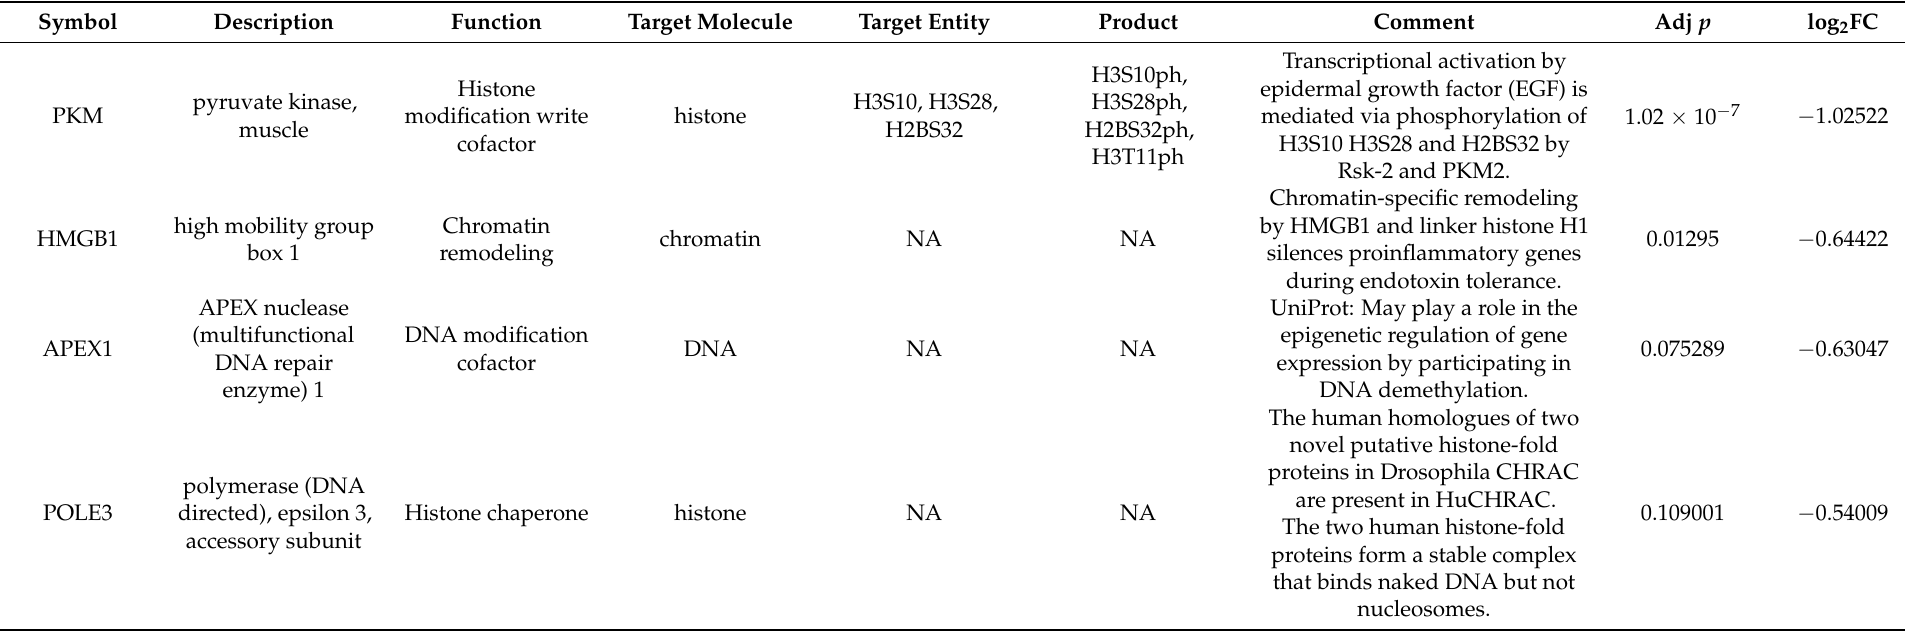
Table 4. Several genes involved in gene expression regulation were also found to be involved in epigenetic modifications. The genes were data-mined and annotated using EpiFactors as a reference database. FC, fold change. NA indicates data not